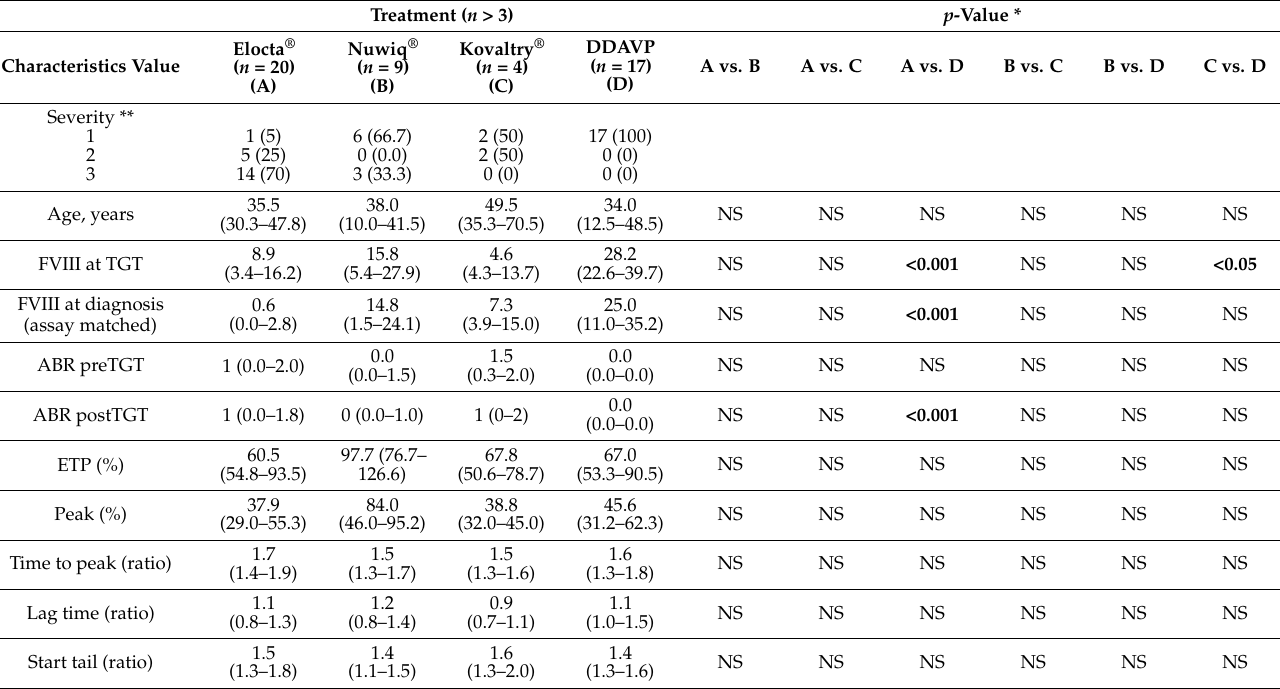
Table 6. Clinical characteristics of the HA patients according to the treatment